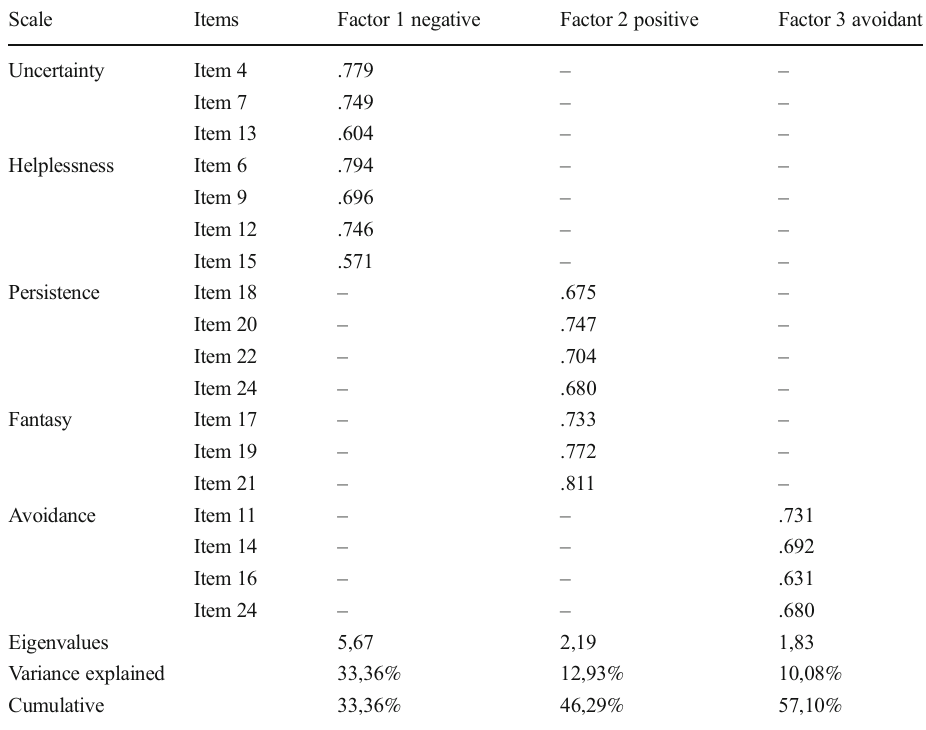
Table 1 Factor structure of the Future Thinking